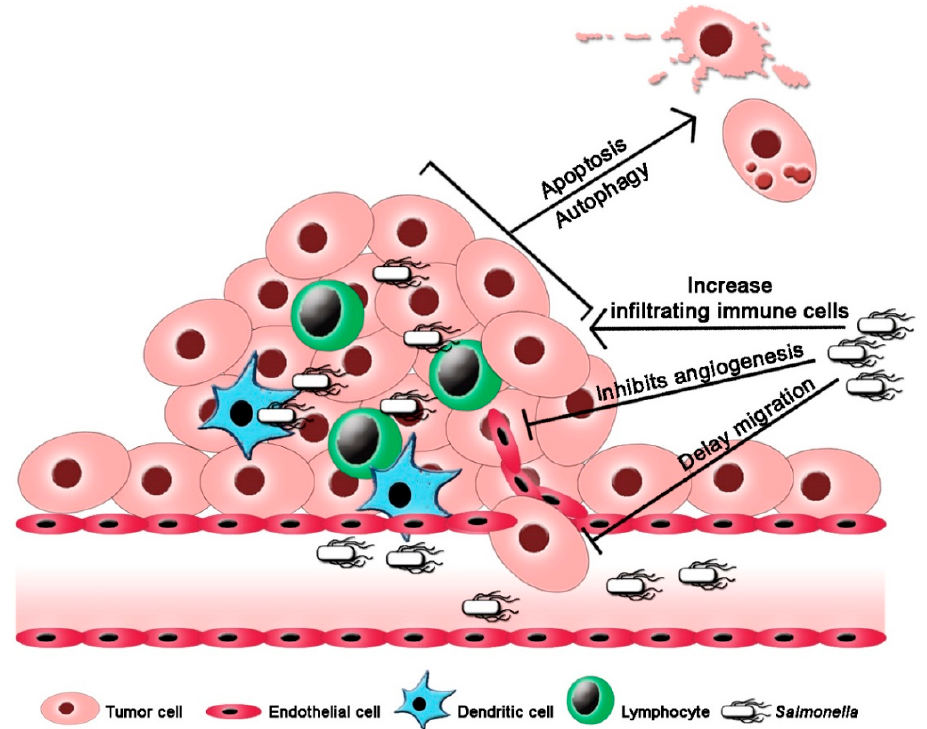
Figure 1. Salmonella -mediated tumor immunotherapy. Salmonella triggers immune cells infiltration into tumor tissue and coax tumor cells self-destruction while preventing tumor microvascularization and delaying tumor cell migration.